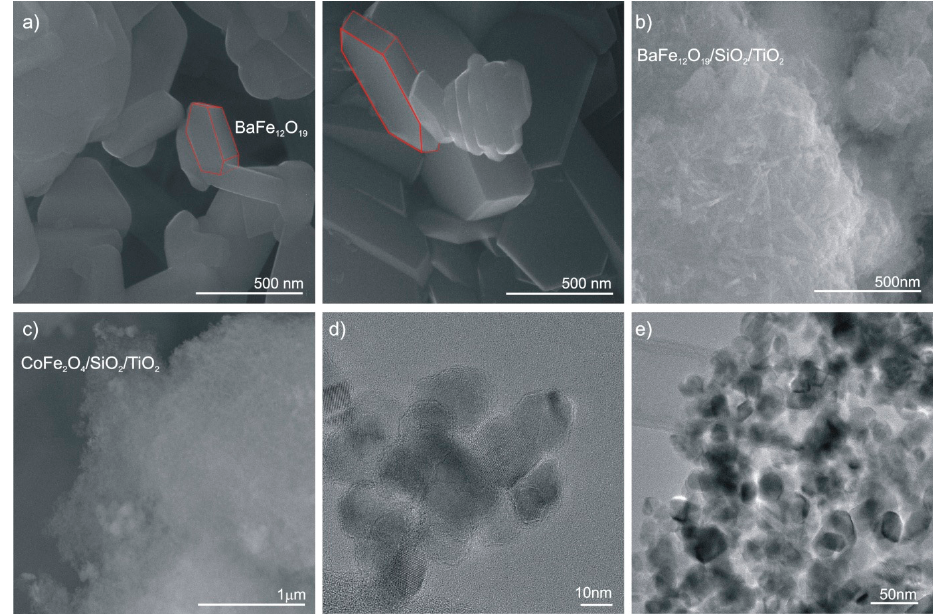
Figure 4. SEM images of barium hexaferrite ( a ); barium hexaferrite coated with SiO 2 and TiO 2 layer ( b ); cobalt ferrite, CoFe 2 O 4 coated with SiO 2 and TiO 2 layer ( c ); TEM images of CoFe 2 O 4 /SiO 2 /TiO 2 ( d ) and CoFe 2 O 4 /SiO 2 /TiO 2 ( e ).